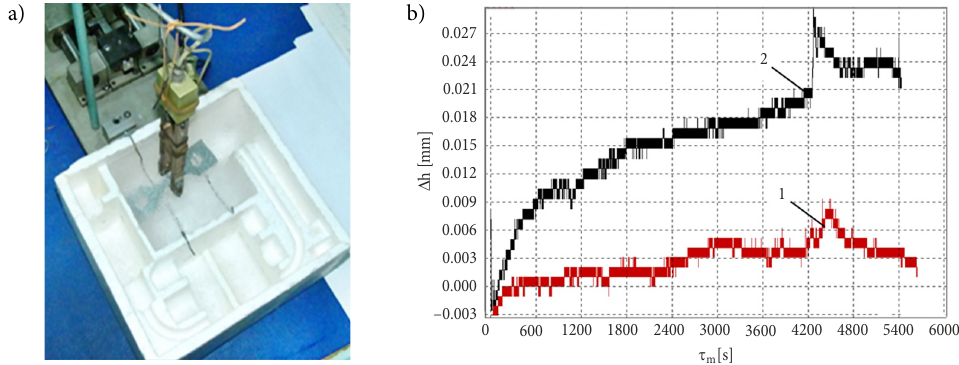
Fig. 10. Width measurement of specimens from the alloy 2024-T3 during HLN for 1 hour: a – specimen in a bath with liquid nitrogen; b – data on the specimen width variation (1 – initial condition; 2 – after the DNP implementation)